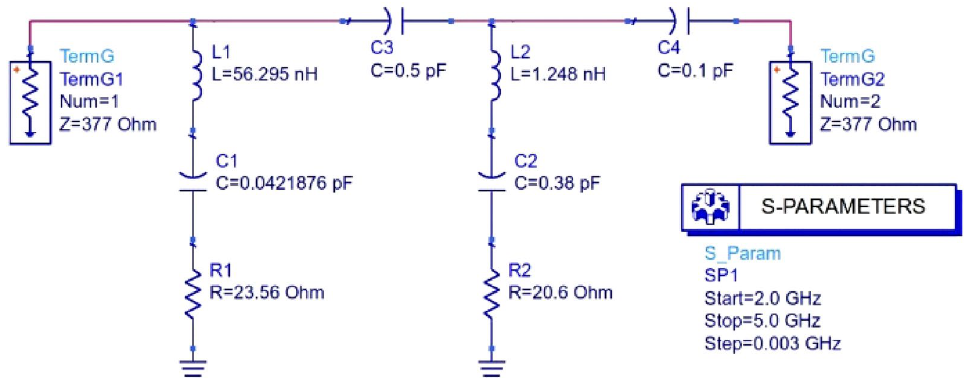
Figure 3. Equivalent circuit of the metamaterial absorber (unit cell/array).